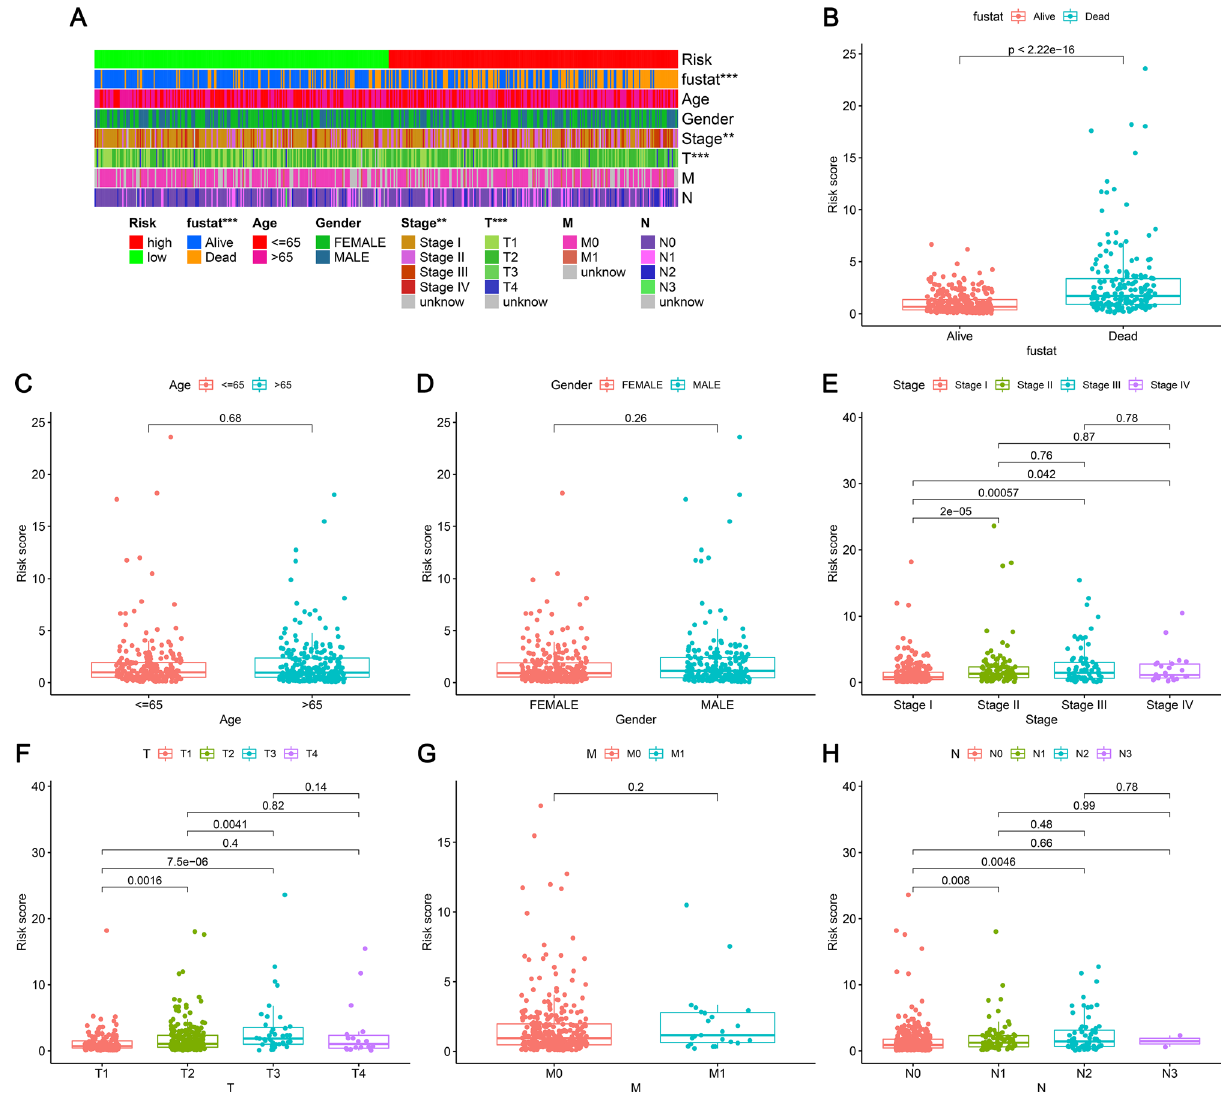
Figure 5. Risk factor model utilized for clinical association analysis in LUAD. ( A ) The clinical correlation strip chart. ( B ) survival status, ( C ) age, ( D ) gender, ( E ) Stage, ( F ) T stage, ( G ) M stage, ( H ) N stage.